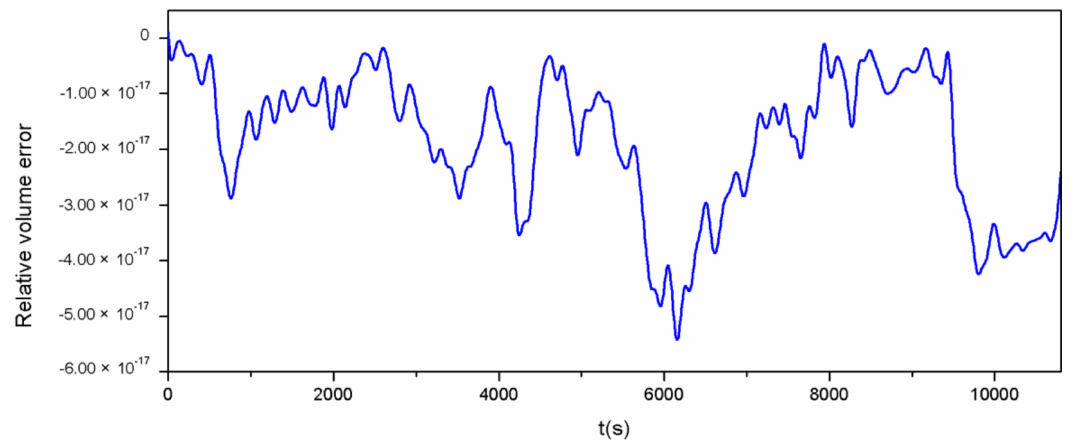
Figure 13. Relative error of total water volume in the parabolic basin.